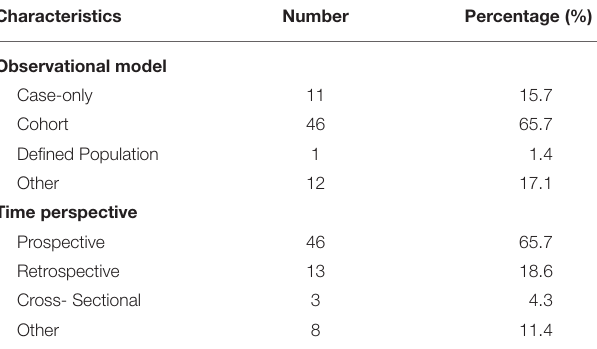
TABLE 3 | Study design elements of observational